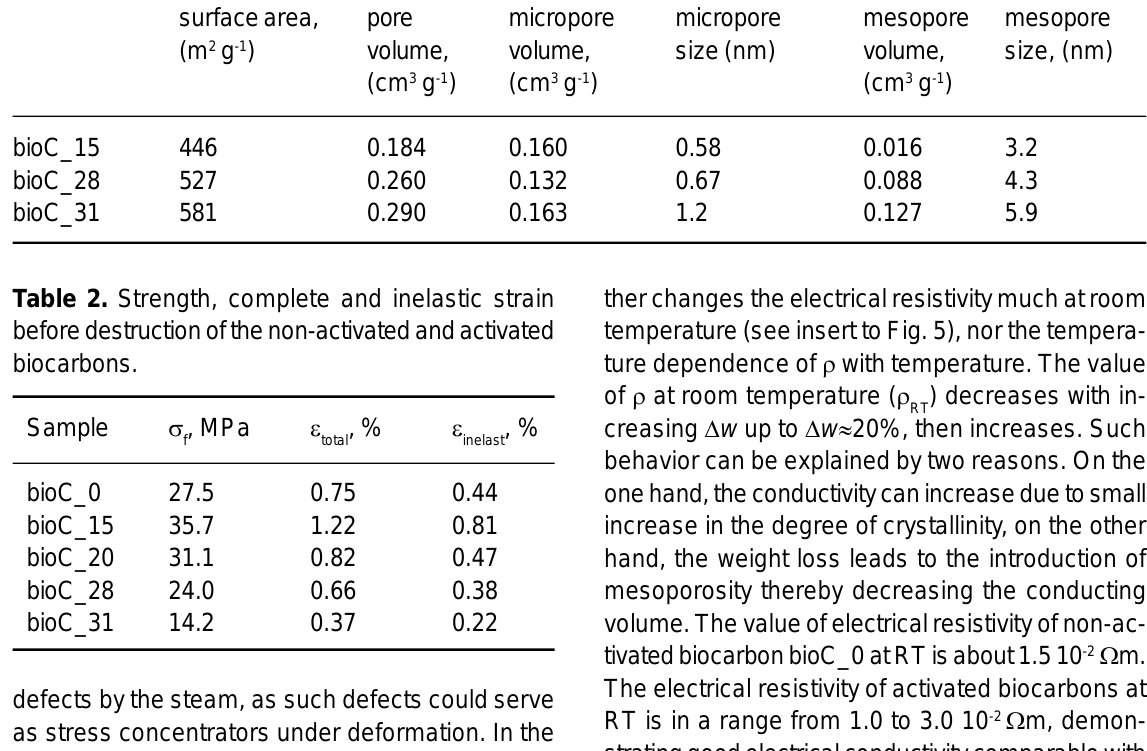
Table 1. Specific surface area, pore volume and pore size of activated samples. Sample